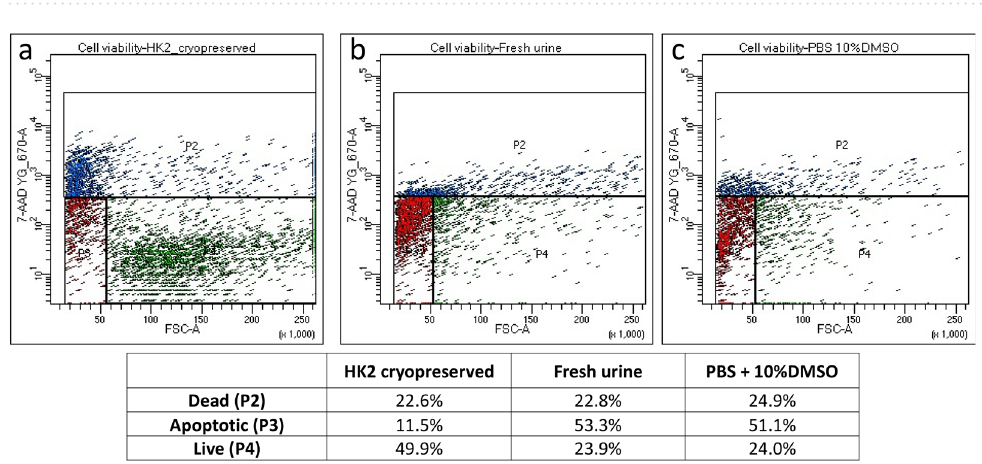
Figure 2. Cell viability. ( a ) HK2 cells cryopreserved in standard (DMEM + 10%DMSO); ( b ) Fresh urinary cells; ( c ) Urinary cells kept at − 80 °C in PBS + 10%